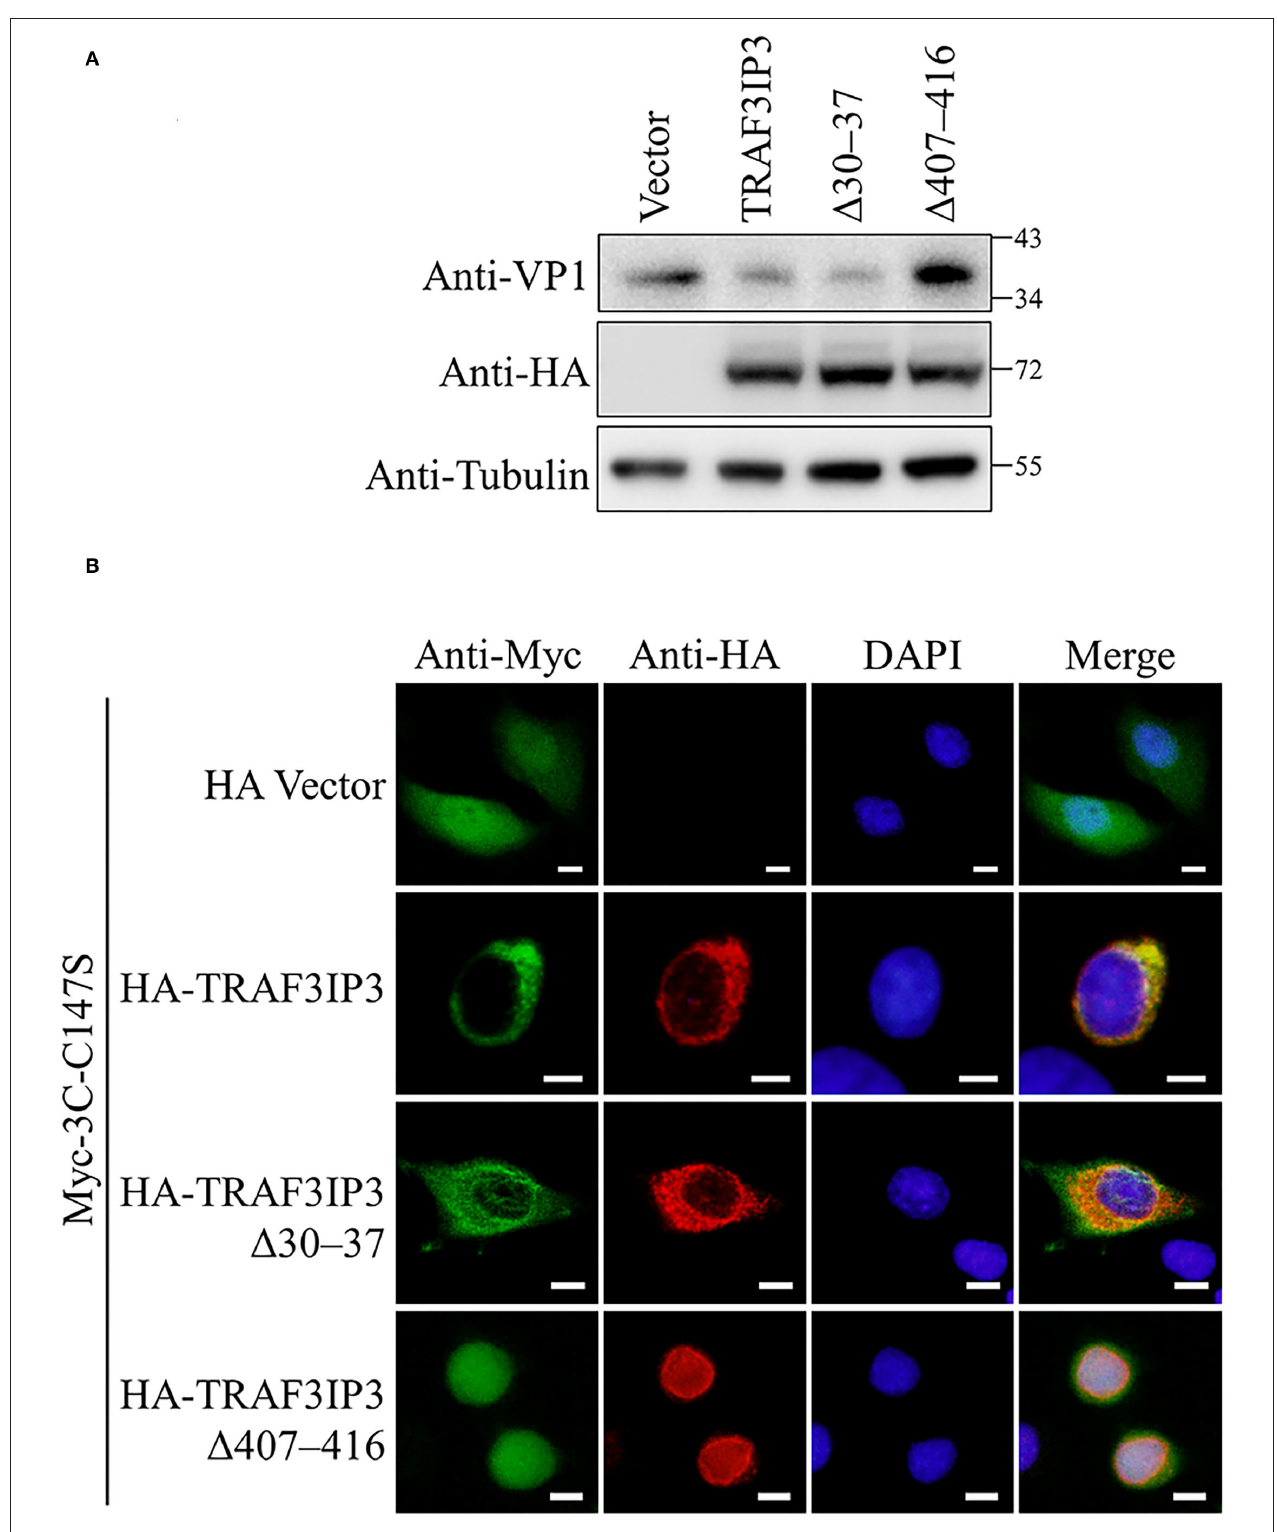
FIGURE 6 | The NES of TRAF3IP3 contributes to the inhibition of EV71. (A) HA-TRAF3IP3 wild-type or deletion mutants were transfected into RD cells, followed by infection with EV71 at an MOI of 1 at 36h post-transfection. Twelve hours later, the cells were collected for Western blotting. (B) HA-TRAF3IP3 wild-type or deletion mutants and Myc-3C-C147S were co-transfected into HeLa cells. Cells were fixed for immunofluorescence after 48h. Scale bars represent 10 µ m.